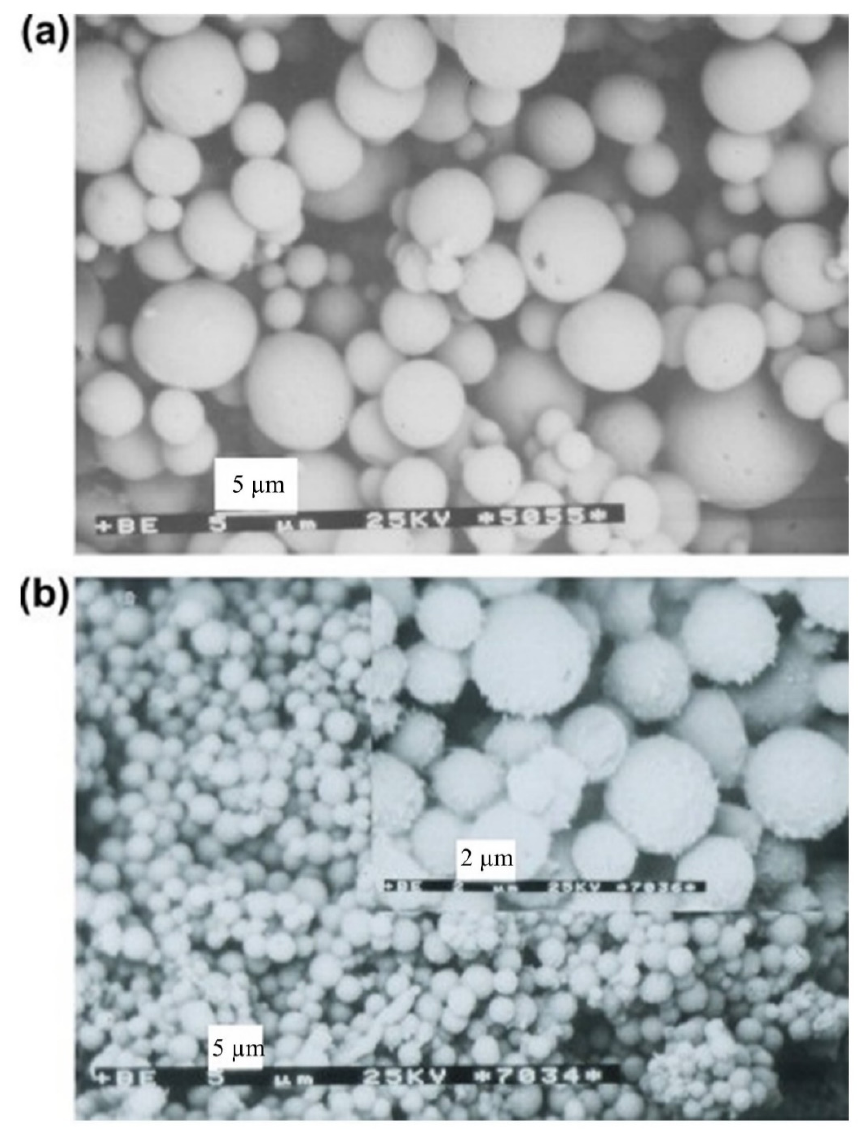
Figure 17. Representative SEM microphotographs of microspheres obtained from the initial ( a ) and oxidized ( b ) PSAGE20SBA80, as studied by Jaszcz et al . Adapted with permission from [50]; published by Elsevier, 2012.